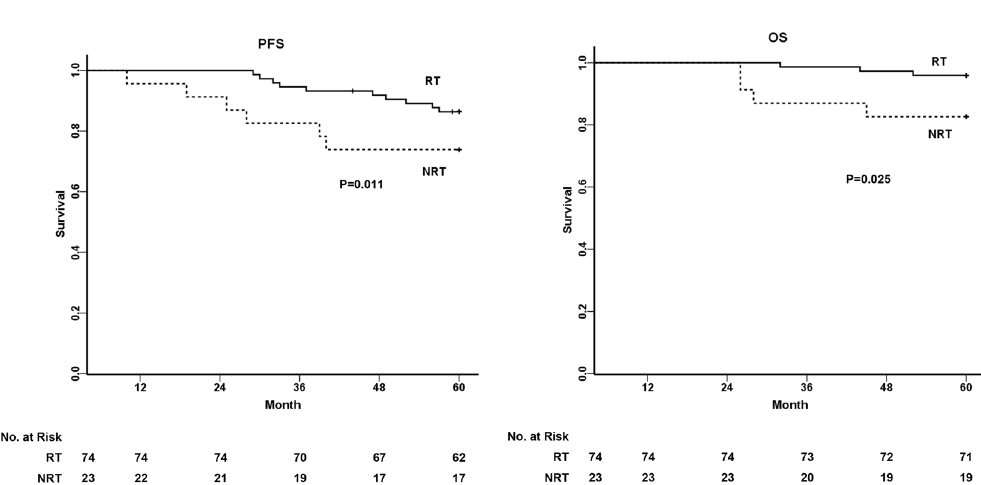
Figure 1. Survival analysis of young patients with SCC who were informed to take adjuvant radiotherapy. PFS and OS of 97 young patients are shown between two study groups: NRT and RT. The five-year PFS in NRT and RT groups were 74.0% vs. 86.4% (P = 0.011), and the five-year OS in NRT and RT groups were 82.6% vs. 95.9% (P =